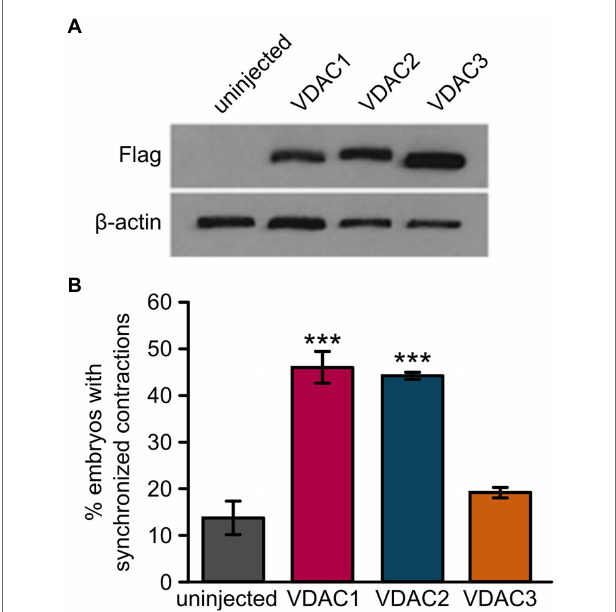
FIGURE 3 | Overexpression of VDAC1 or VDAC2 but not VDAC3 restores rhythmic cardiac contractions in tremblor/ncx1h mutants. (A) Western blot with anti-FLAG antibody after SDS-PAGE with lysate from 32 hpf uninjected embryos or embryos injected with 25 pg. of C-terminally FLAG-tagged VDAC mRNA demonstrates that all VDAC mRNAs are expressed at comparable levels in embryos. β -actin was used as a loading control. (B) While injection of 25 pg. VDAC1 or VDAC2 mRNA significantly restored rhythmic cardiac contractions in 1-day-old tremblor/ncx1h mutant embryos (46.5 ± 3.4%, N = 3, n = 120, and 44.8 ± 0.4%, N = 3, n = 134, respectively, as opposed to 14 ± 3.5%, N = 3, n = 175 in uninjected siblings), injection of 25 pg. VDAC3 failed to recapitulate this effect (19.4 ± 1.1%, N = 3, n = 114). Overall rescue percentages represent the mean rescue percentage ± s.e.m. from N independent experiments, using a total of n